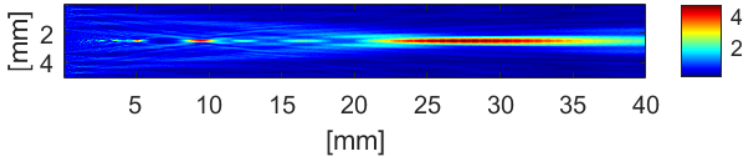
Figure 3. Simulated radiation pattern of the ultrasonic transducer.